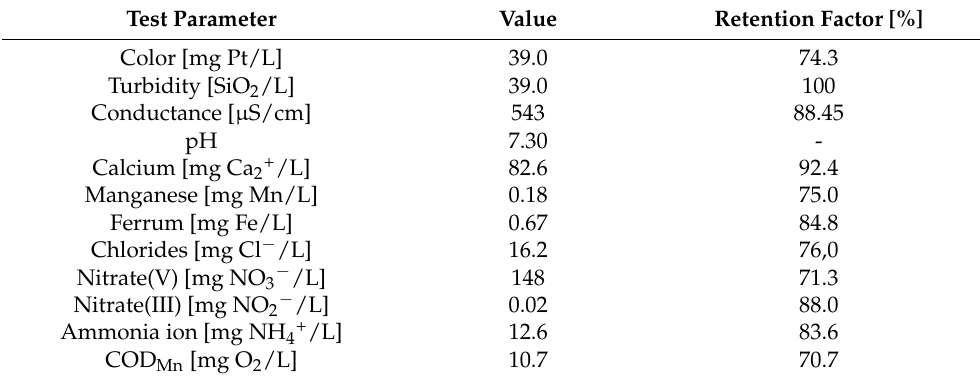
Table 2. The results of the removal of individual indicators at an increased dose of NH 4 + ammonia ion and NO 3 − .